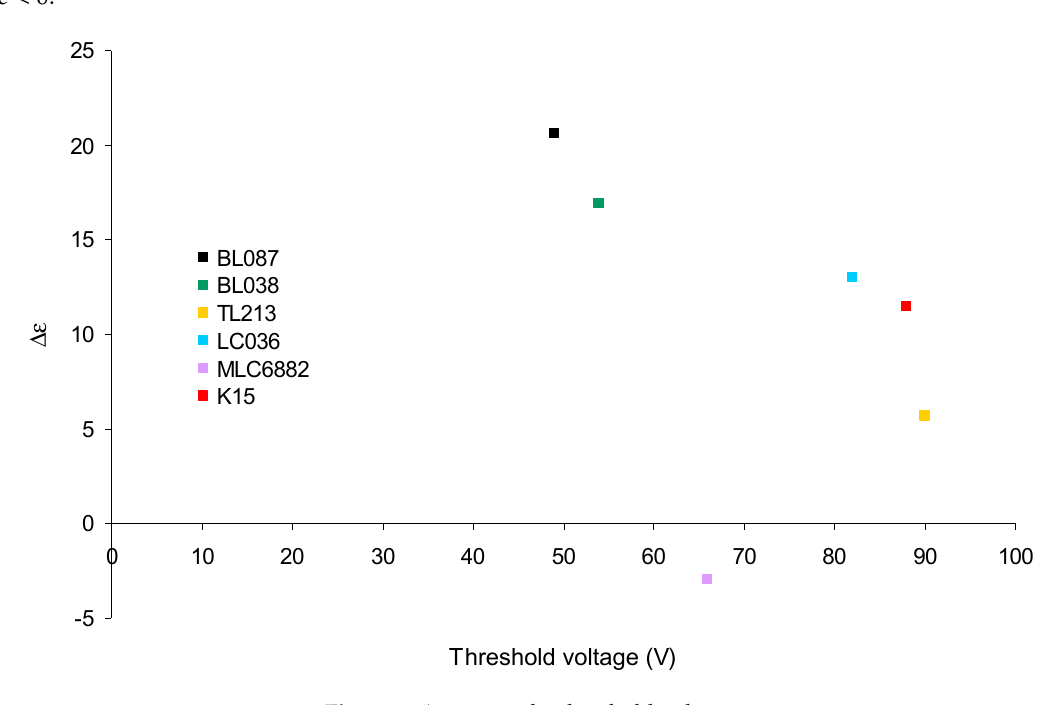
Figure 4. Δε versus the threshold voltage. Figure 4. ∆ ε versus the threshold